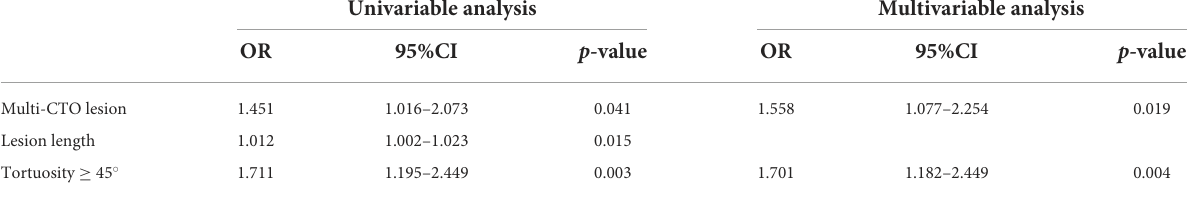
TABLE 6 Univariable and multivariable logistic regression for 1-year angina improvement in patients with low eGFR ( < 90 mL/min/1.73 m 2 ) after successful